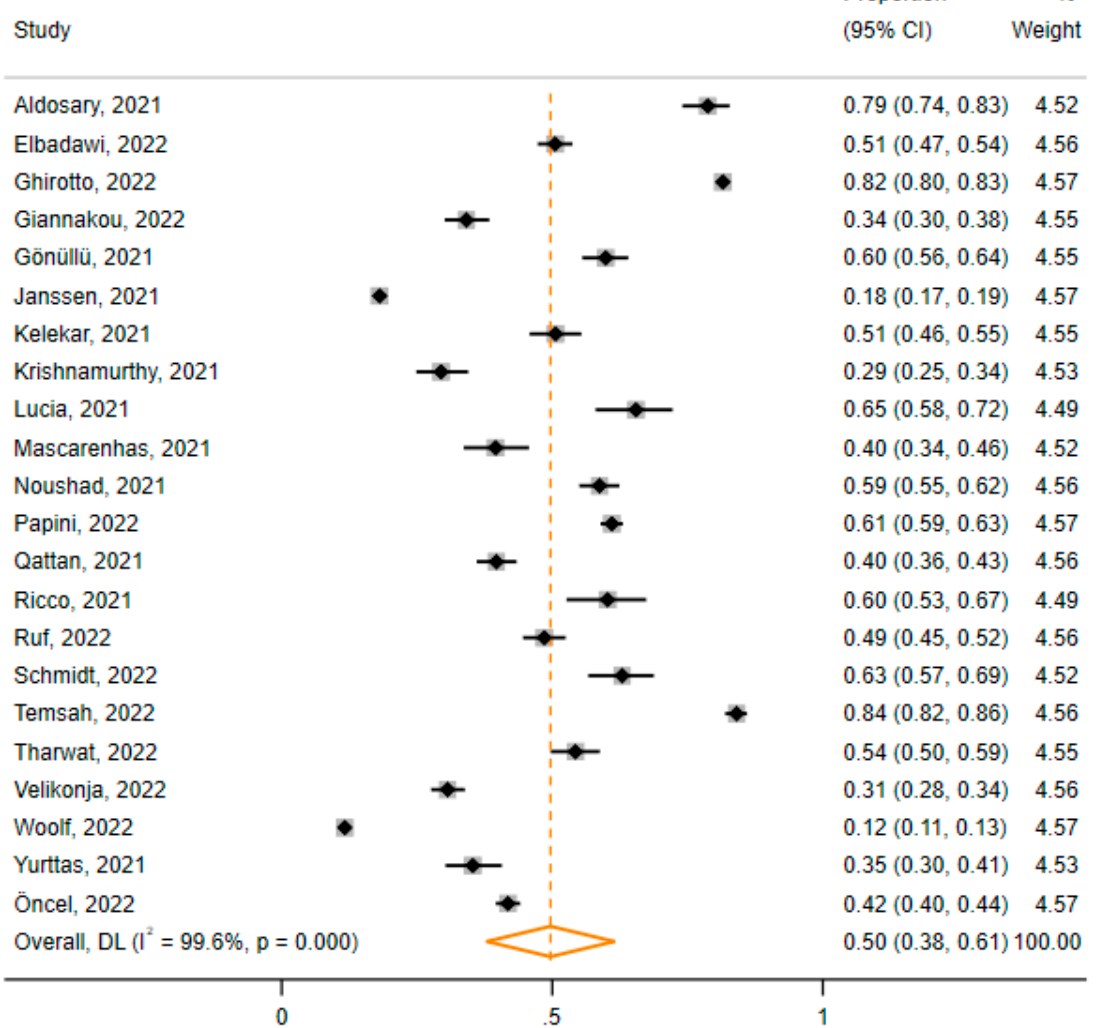
funnel plot. According to the LFK index, with a cut-off point of |2| (minor vs.